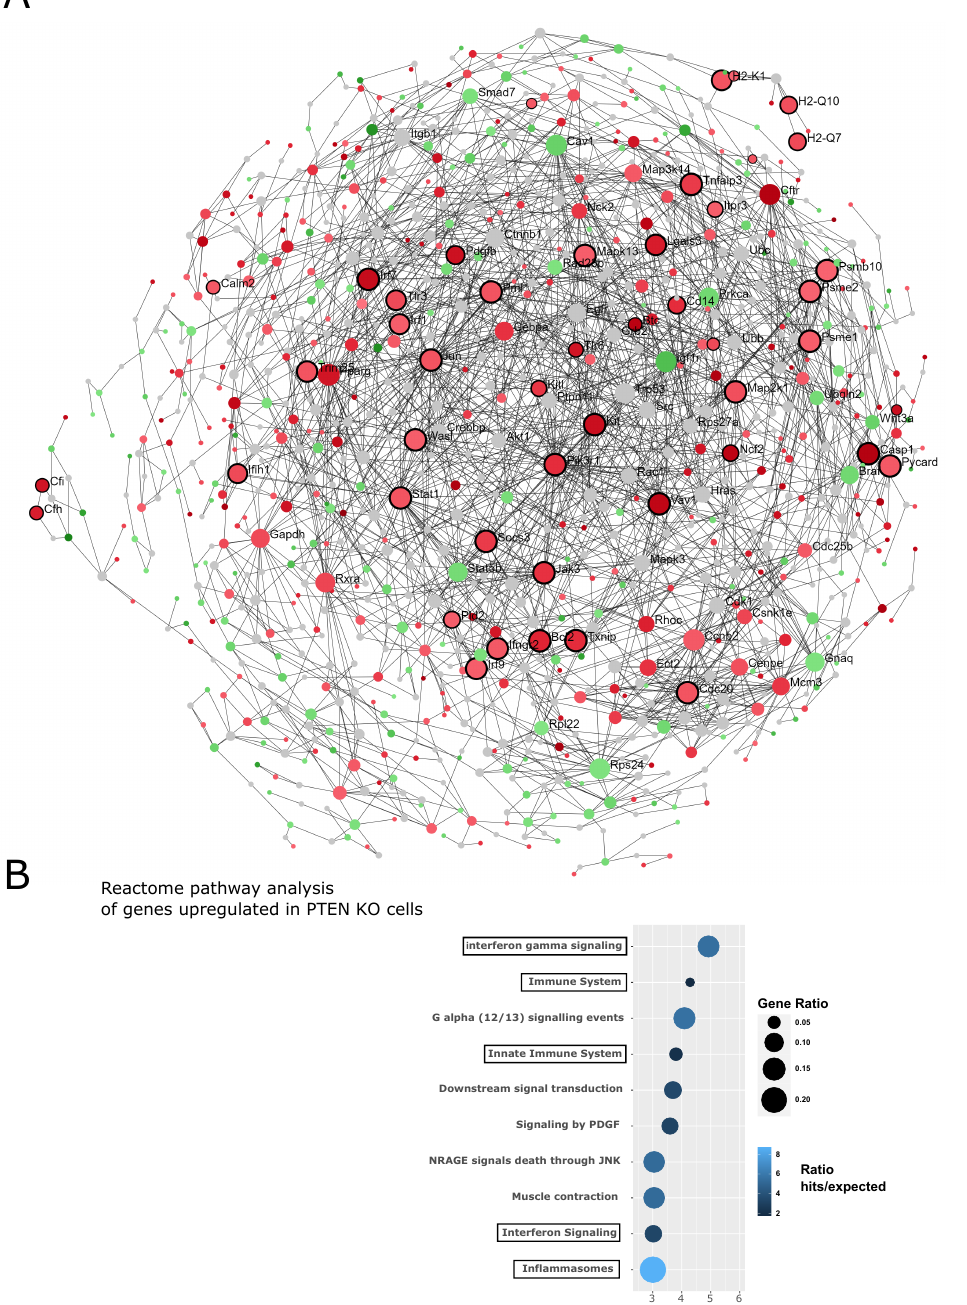
Figure 8. Loss of PTEN activates NF- κ B and inflammatory pathways. ( A ) A dataset of WT- and PTEN-deficient prostate epithelial cells from a mouse model of prostate cancer [47] was reanalyzed